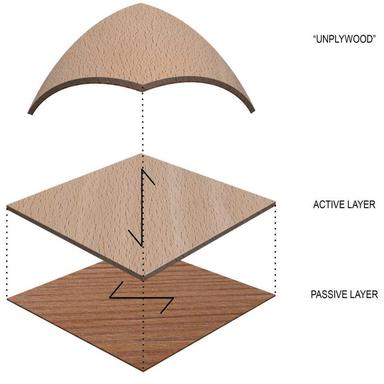
Realization of an "unplywood".